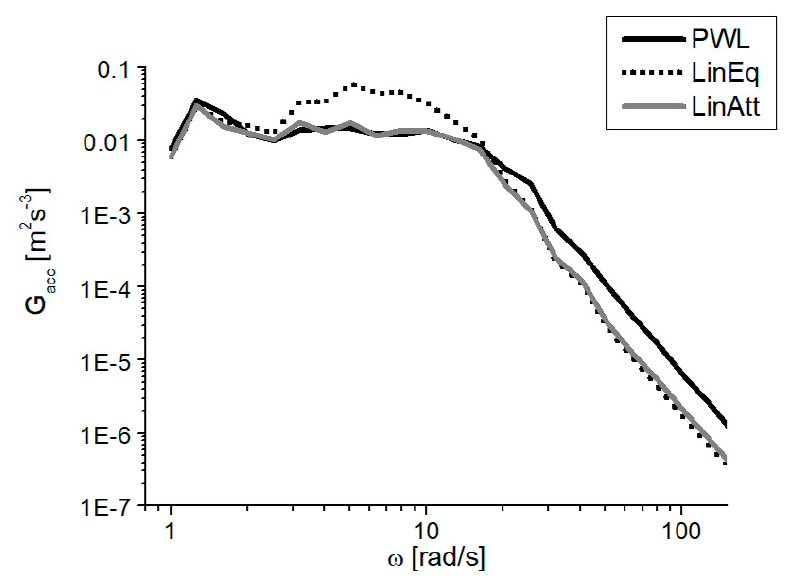
Figure 11. Spectral densities of acceleration for PWL, linear equivalent and attached linear systems. The relative errors between the areas under spectral densities that represent the variances of acceleration, given in Table 9, advocate the efficiency of the proposed